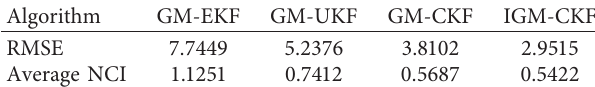
Table 2: RMSE of various filtering algorithms.